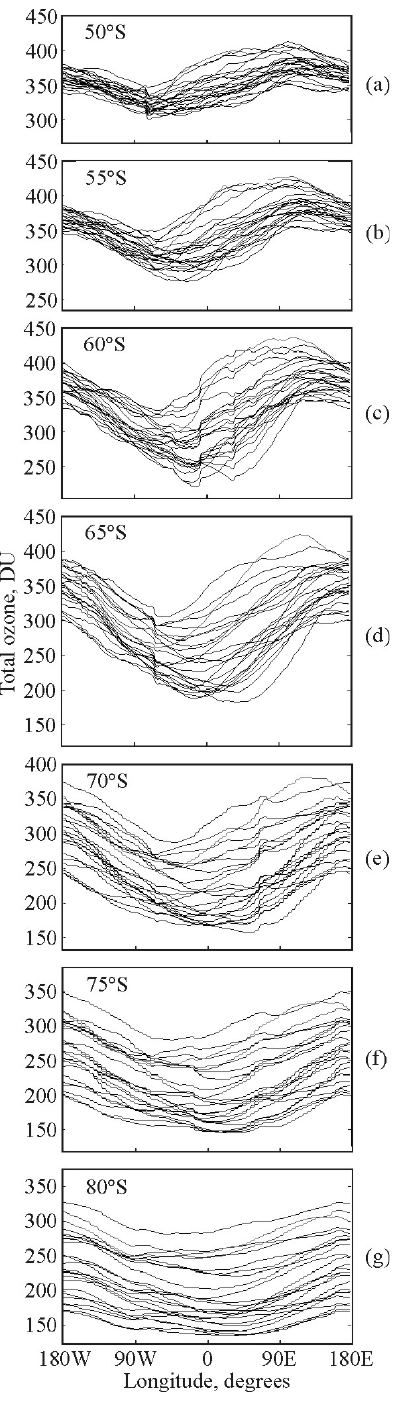
Fig. 2. Interannual variations of the mean spring distribution of the TOMS total ozone at the 7 latitudes between 50 ◦ S and 80 ◦ S.